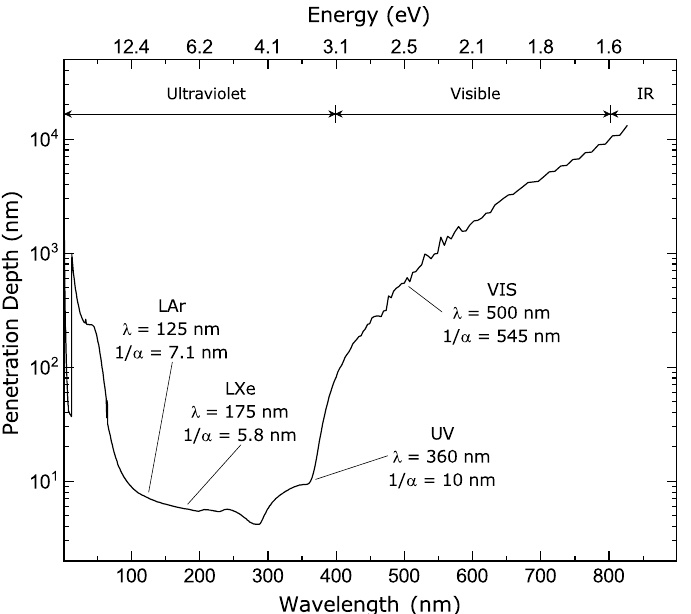
Figure 11. Photon penetration depth in silicon as a function of the wavelength (data taken from [111]). The minimum penetration of 4.2 nm is at a wavelength of 285nm. The wavelengths for LXe (175nm) and LAr (125nm) are